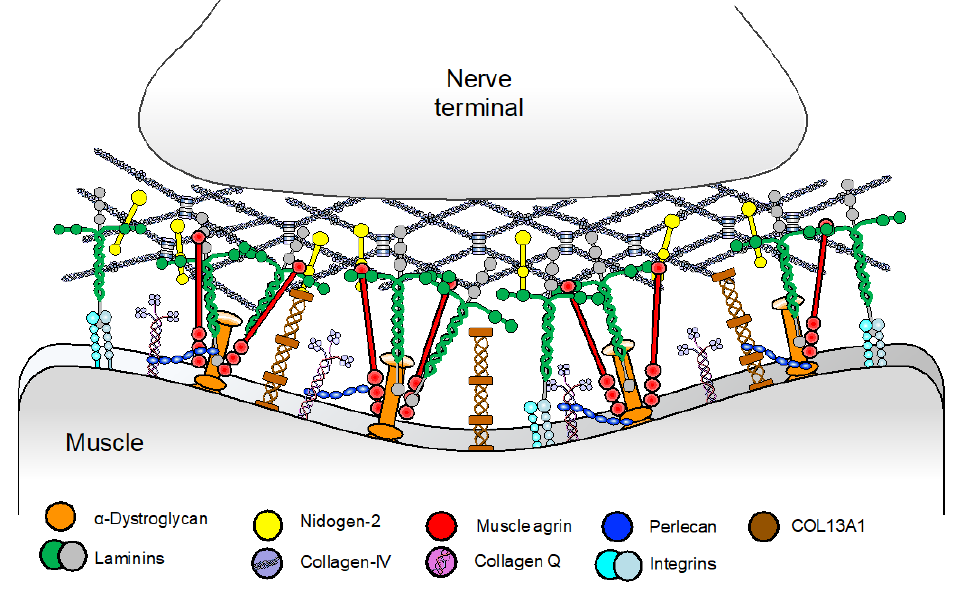
Figure 4. Schematic representation of the synaptic basal lamina and its main components. Laminins are heterotrimeric proteins of high molecular weight formed by the incorporation of α , β , and γ chains. Laminins self-assemble, but also interact with integrins and α -dystroglycan [41]. Collagen IV, which is the most abundant protein at the basal lamina, self-assembles into dimers and hexamers thanks to its globular domains [41]. Nidogen-2 are non-collagenous glycoproteins responsible for linking collagen IV and laminin networks [42,43]. Additional collagens include COL13A1 [44] and COLQ, a collagen like tail responsible for anchoring AChE to the synaptic cleft. Muscle agrin binds to the basal lamina via laminin [45] and α -dystroglycan [46], and this is important for maintenance of the NMJ [47]. This differs from the role of neuronal agrin as a key organiser of the postsynaptic apparatus via the AChR clustering pathway [48]. Perlecan, another synaptic heparan sulphate proteoglycan is linked to both ColQ [49] and α -dystroglycan [50].